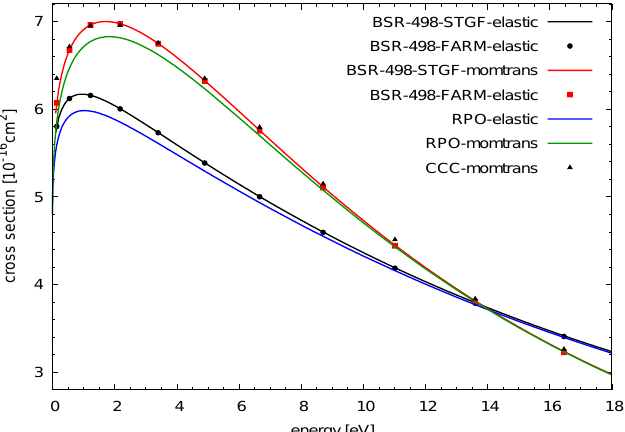
Figure 2. Angle-integrated elastic and momentum-transfer (momtrans) cross section for e-He scat- tering. The lines show the present results obtained with RPO and the STGF asymptotic code for the BSR-498 model. The symbols show the same results for the FARM asymptotic package and the CCC results of Fursa and Bray [10] taken from the LXCat database